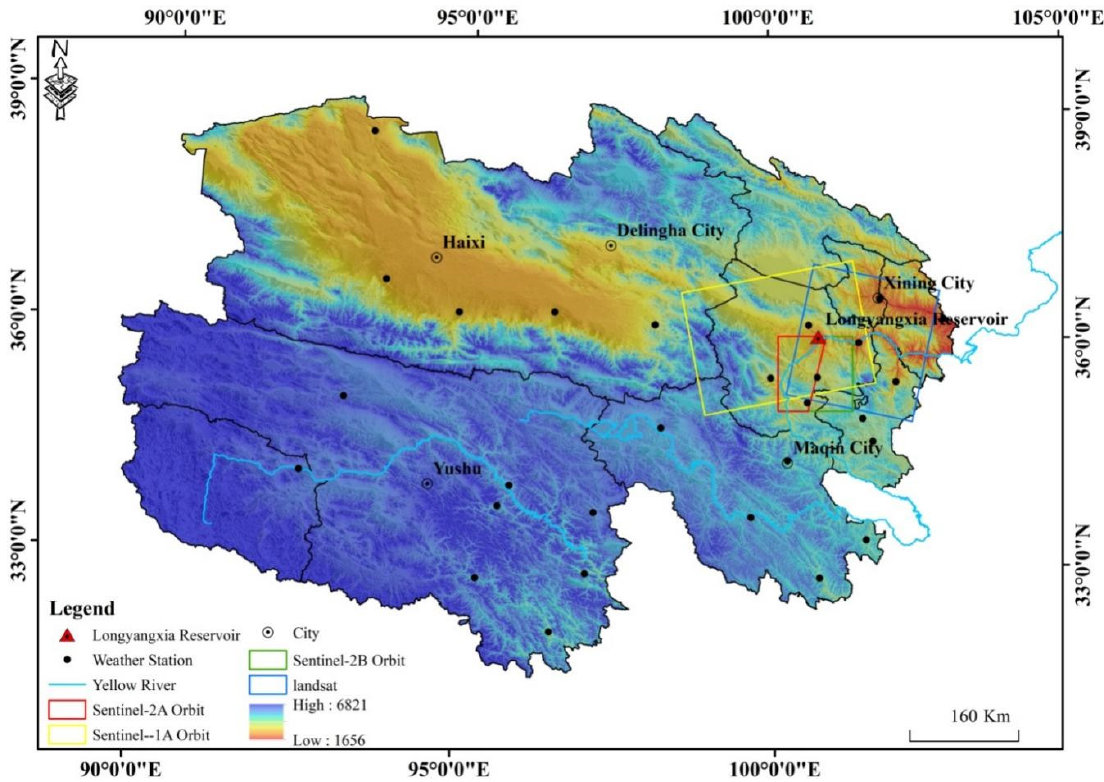
Figure 4. Track coverage of the SAR image and multisource remote sensing image data in the study area. Table 1. Sentinel-1A data parameters.